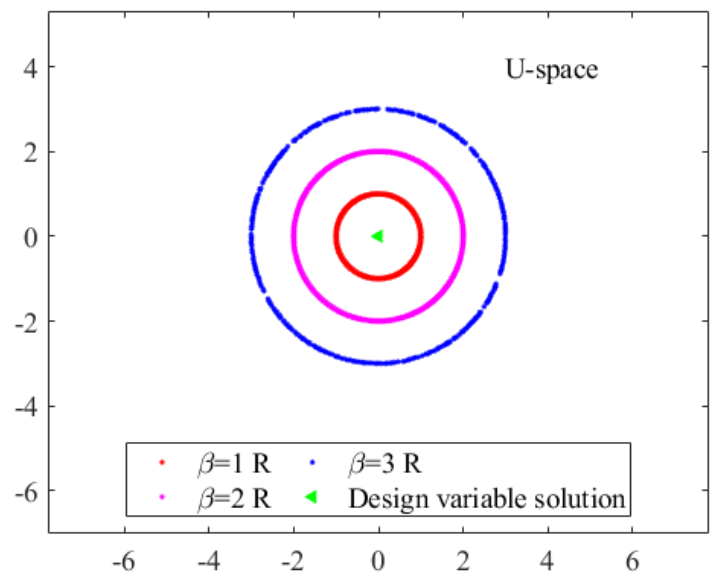
Figure 4. The generation of the accompanying samples. 263